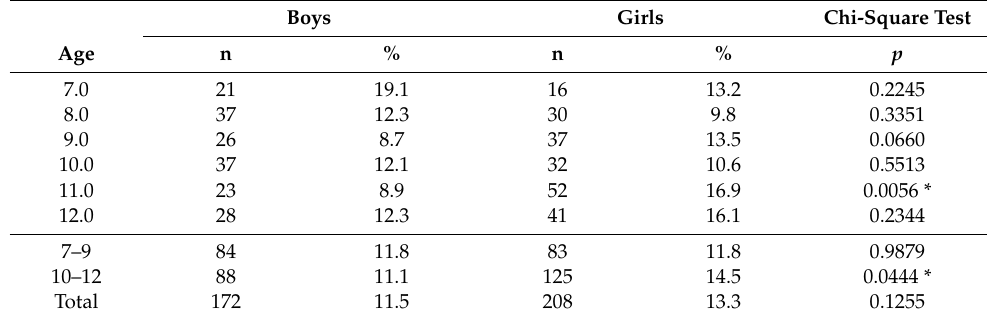
Table 3. The prevalence of thinness in rural boys and girls according to age